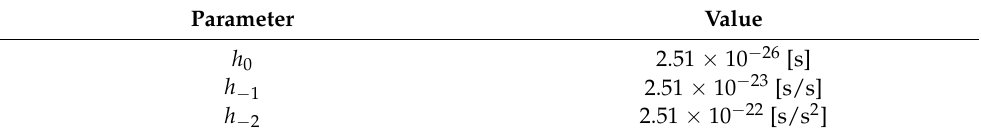
Table 1. Clock parameters for oven-controlled crystal oscillator [26].